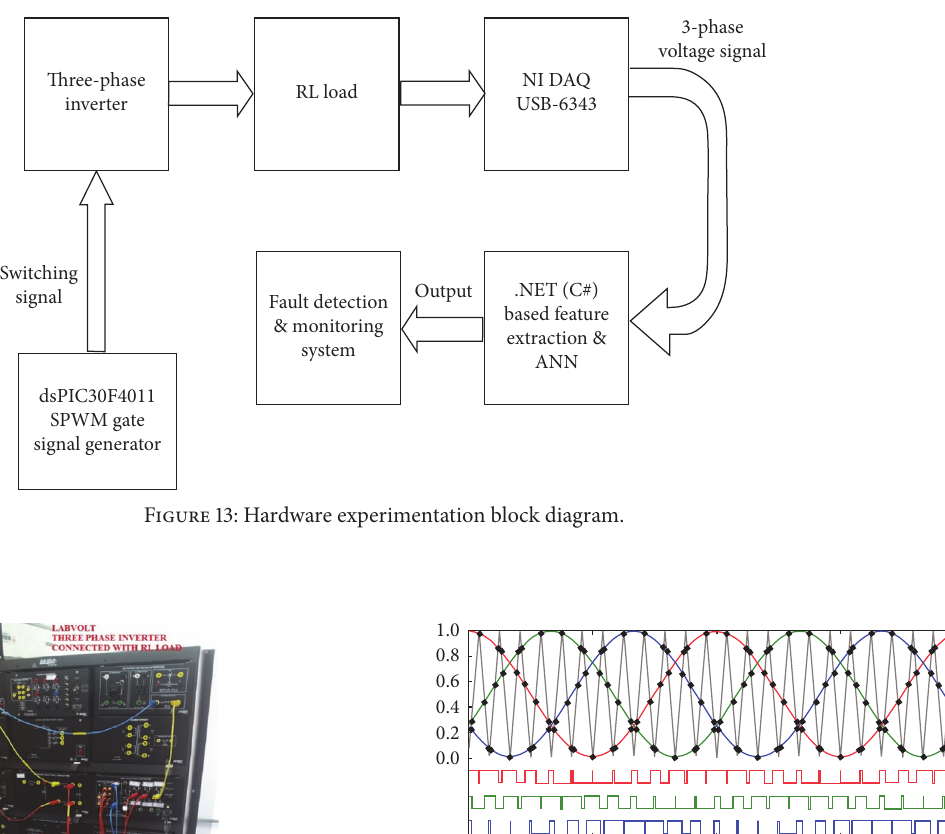
Figure 15: SPWM signal.